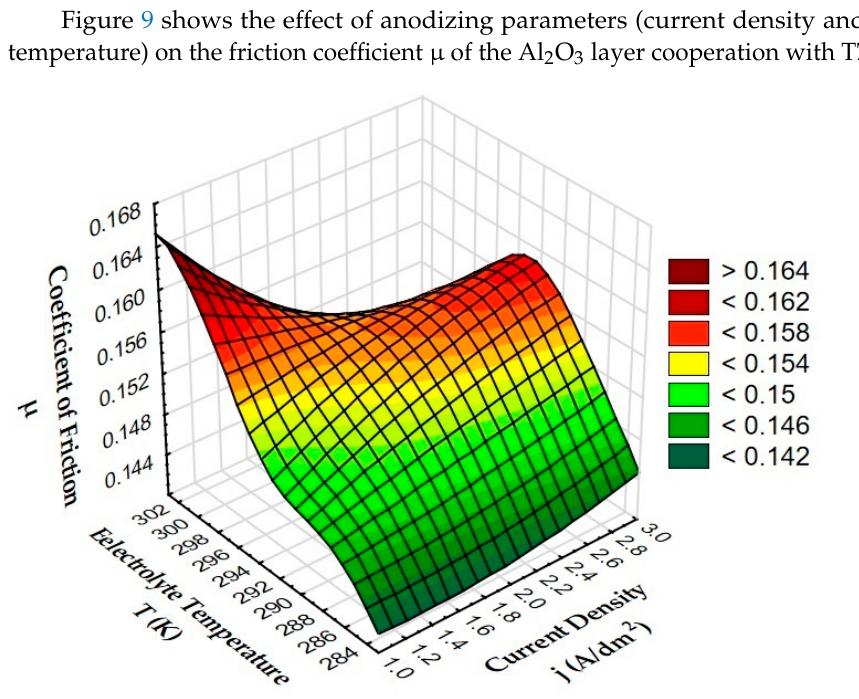
Figure 9. Dependence of the friction coefficient µ of oxide layers on the current density and electrolyte temperature.